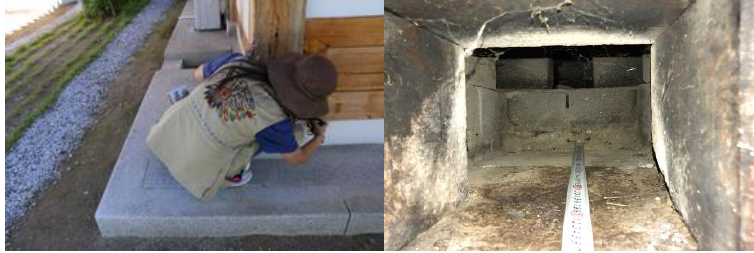
Figure 2. Monitoring method for the Hanok maintenance: visual inspection.